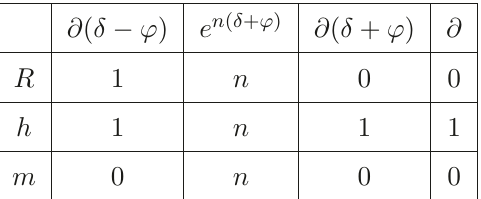
Table 1 . Grading of basic elements of the commutative vertex algebra Gr R Π. The R -filtration on Π is easily read off based on the classical limit, with the important additional simplification that there are no nontrivial relations amongst operators in